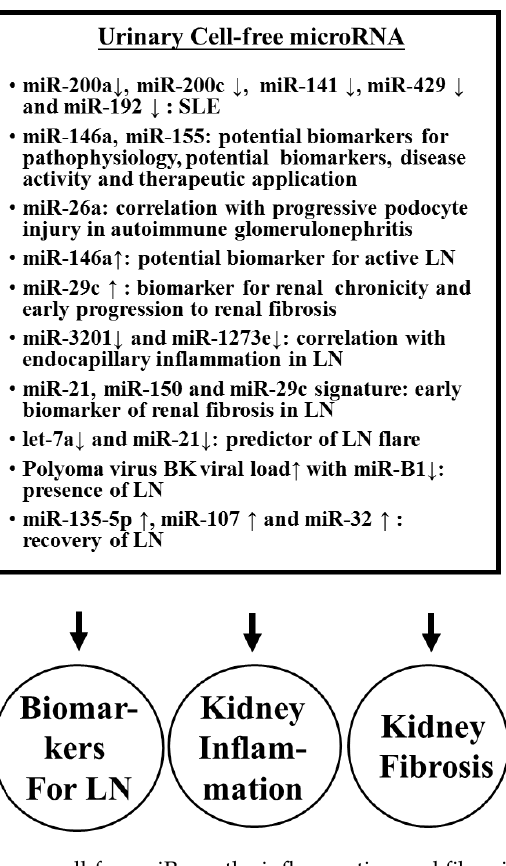
Figure 3. The effect of urinary cell-free miRs on the inflammation and fibrosis in lupus nephritis (LN) and as biomarkers/biosignatures for SLE and LN.